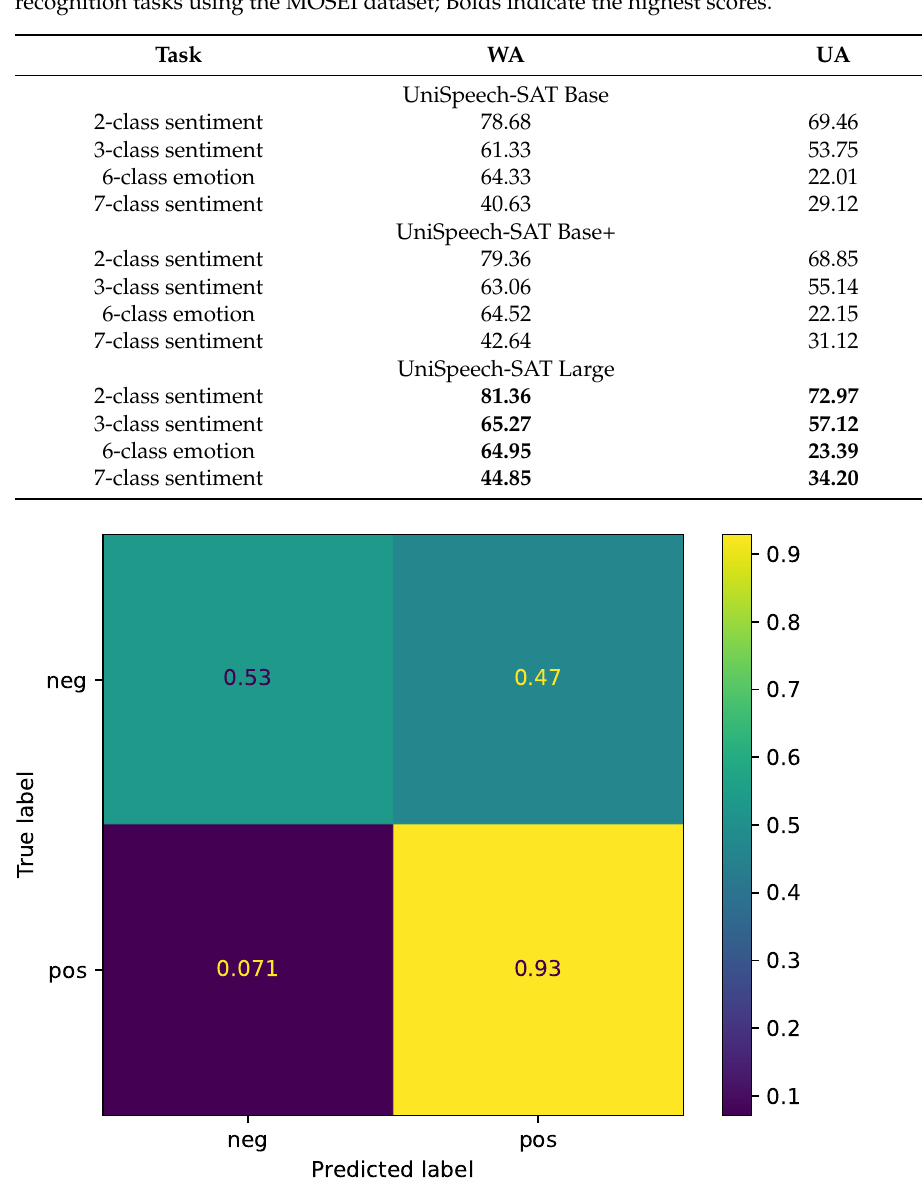
Figure 2. Normalized confusion matrix for two-class sentiment